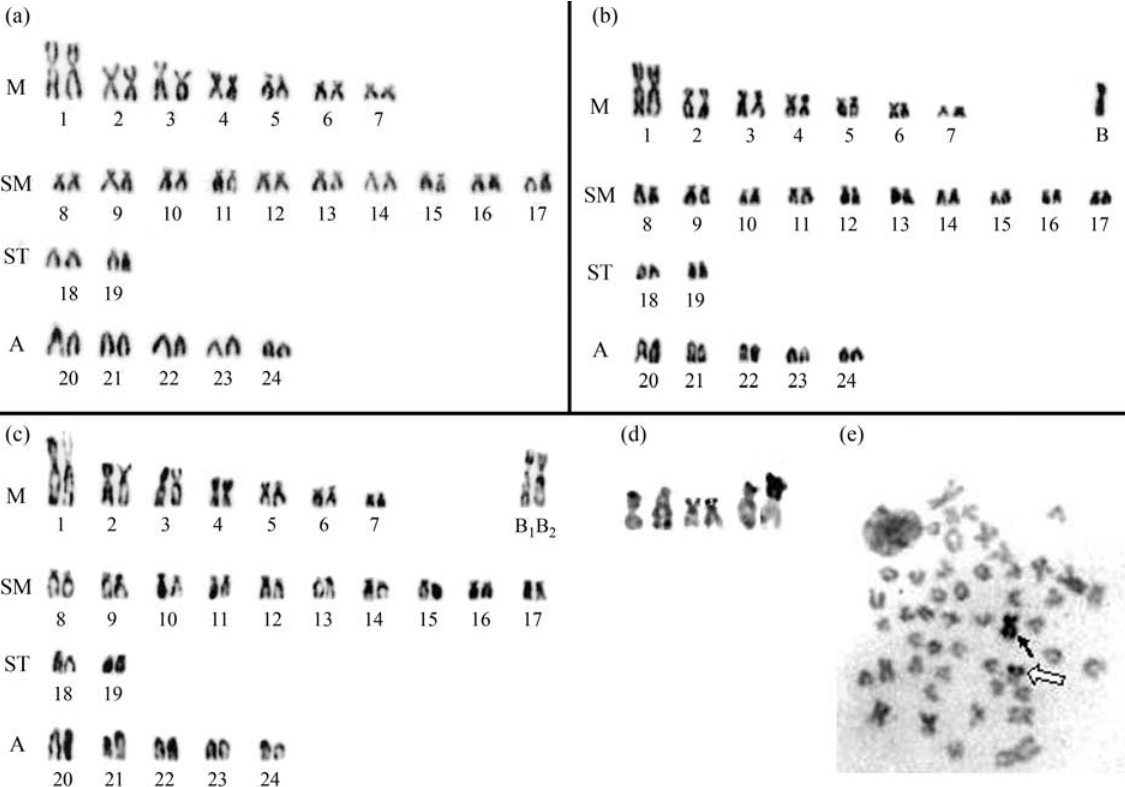
Figure 1 - Karyotypes of A. eigenmanniorum from the Caetano Stream, presenting 48 chromosomes (a), 49 chromosomes with 1 B chromosome (b), and 50 chromosomes with 2 B chromosomes (c). In (d) Ag-NOR bearing chromosomes - from left to right: 3 rd metacentric chromosome, an acrocentric chro- mosome (which is rarely detected), 4 th metacentric pair, and 1 st submetacentric pair, highlighting the size polymorphism of the NOR site. In (e) C-banded metaphase: the small black arrow indicates the heterochromatic supernumerary chromosome; the thick white one indicates the metacentric NOR bearing